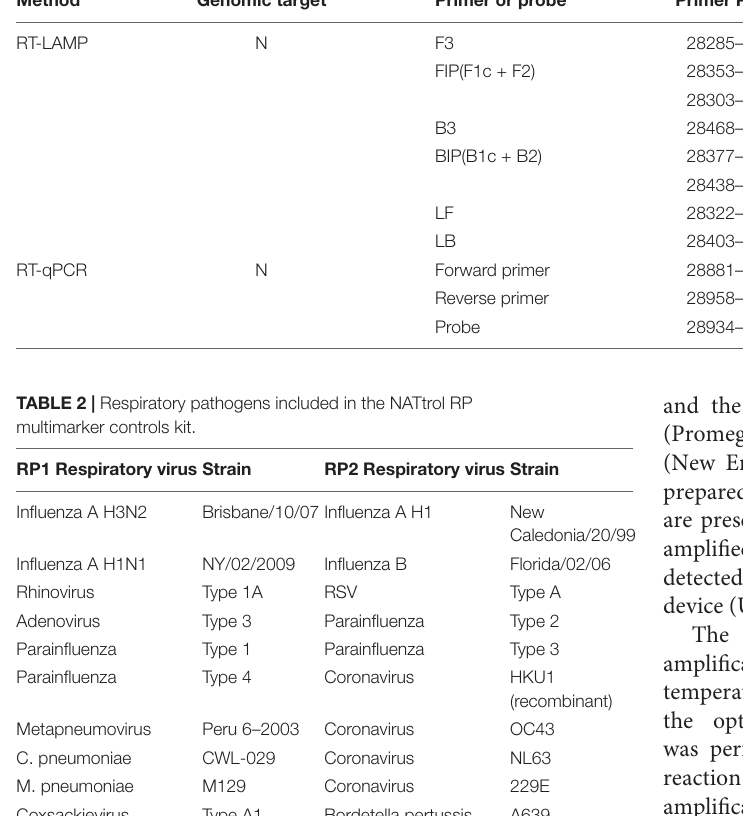
TABLE 1 | Primer and probe sequences for the SARS-CoV-2 RT-qPCR and RT-LAMP assays. Method